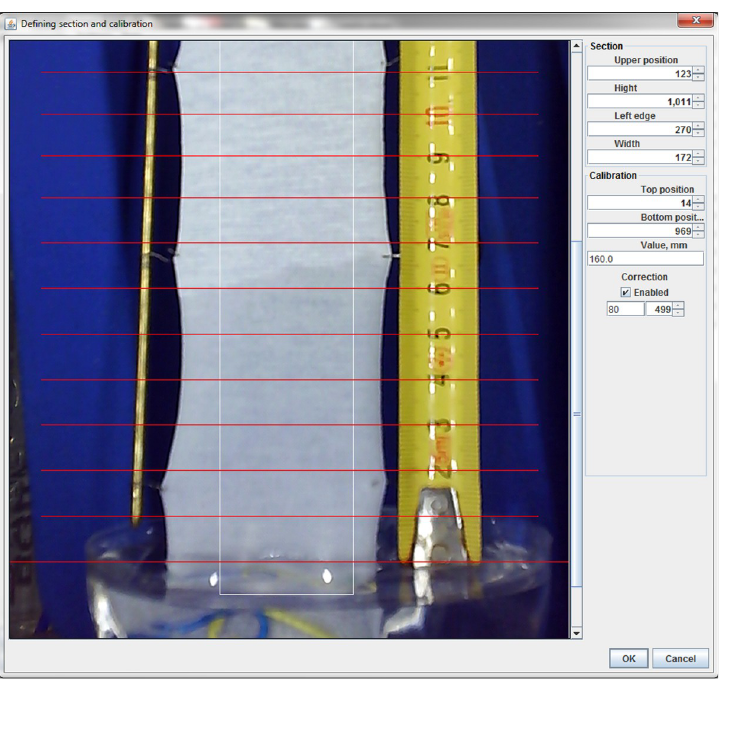
Fig 6. Screenshot of the interface for defining the section and